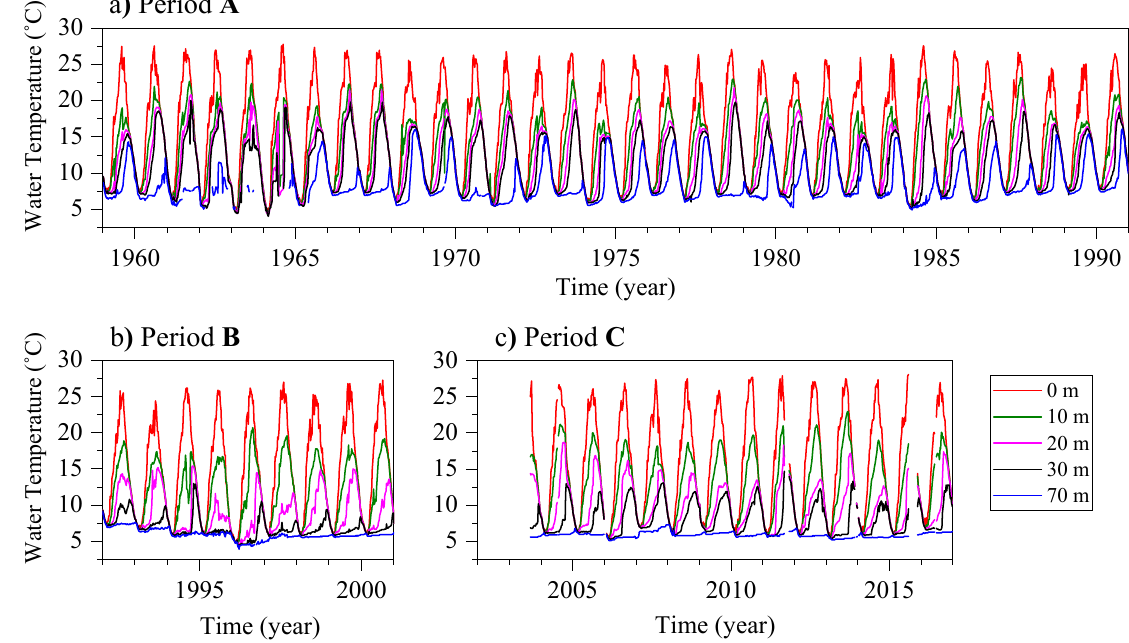
Figure 4. Long-term fluctuations in water temperature at different depths for the three periods ( a – c ). Data are unavailable for 2002 and largely incomplete for 2003.